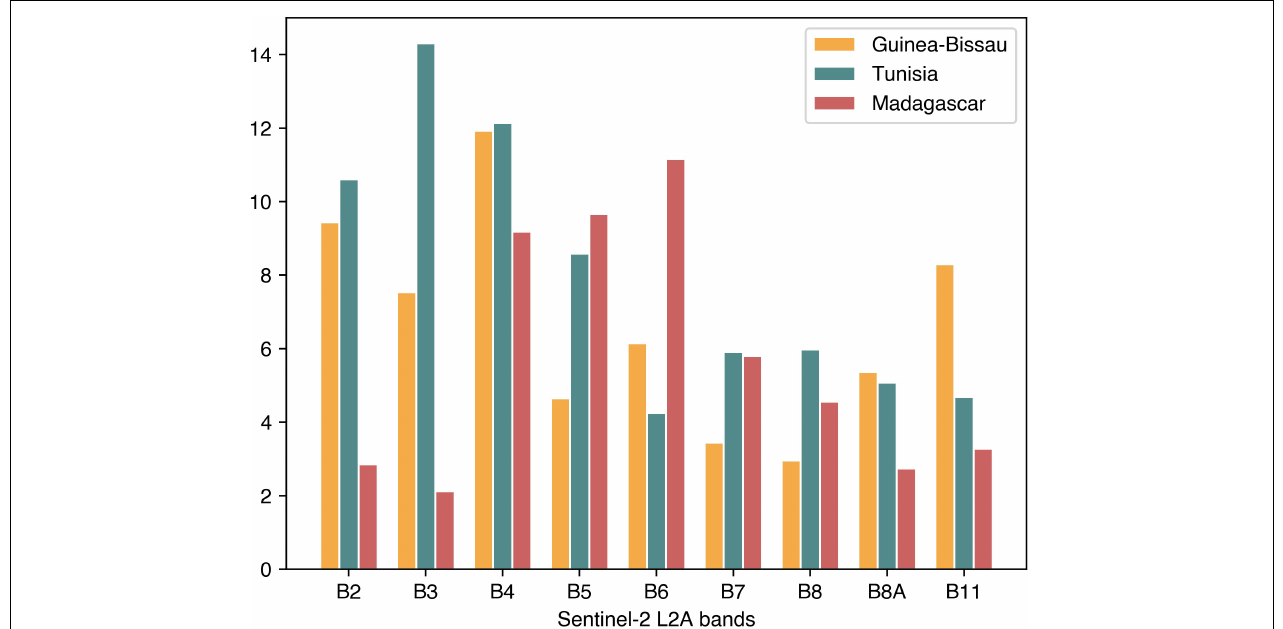
FIGURE 5 | Random Forest Sentinel-2 L2A band variable importance for TZ and CW